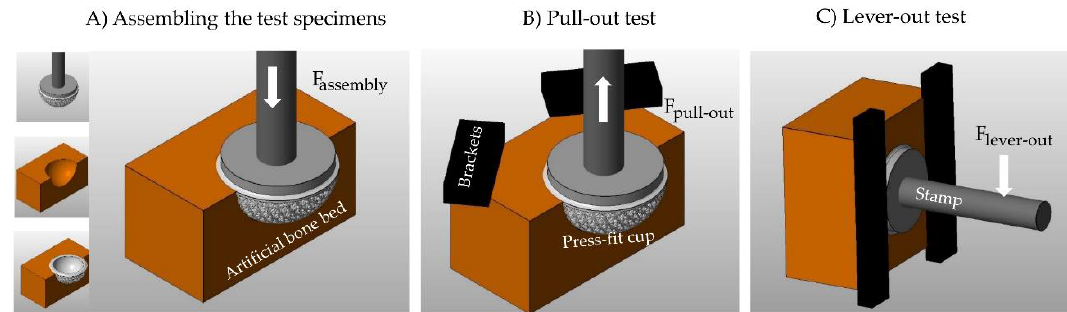
Figure 2. Schematic representation of the experimental test environment for determining the fixation strength. ( A ) Inserting the press-fit cup into the artificial bone cavity; ( B ) Pull-out test; ( C ) Lever-out